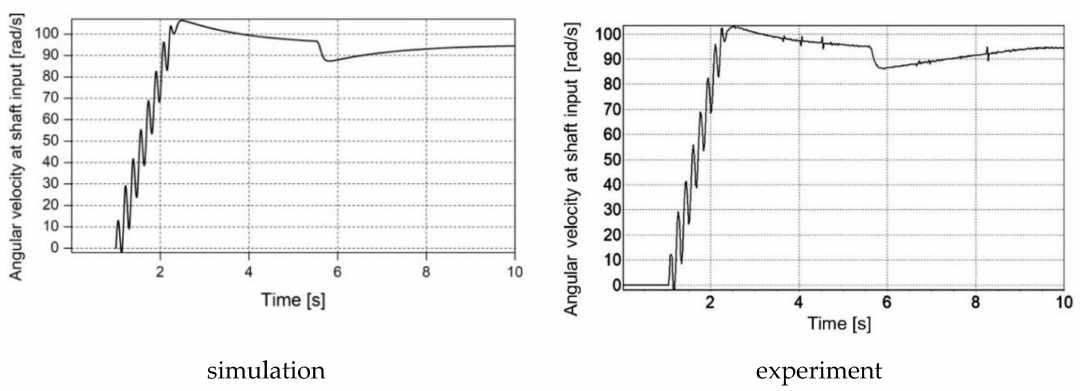
Figure 8. Angular velocity at shaft input vs. time.